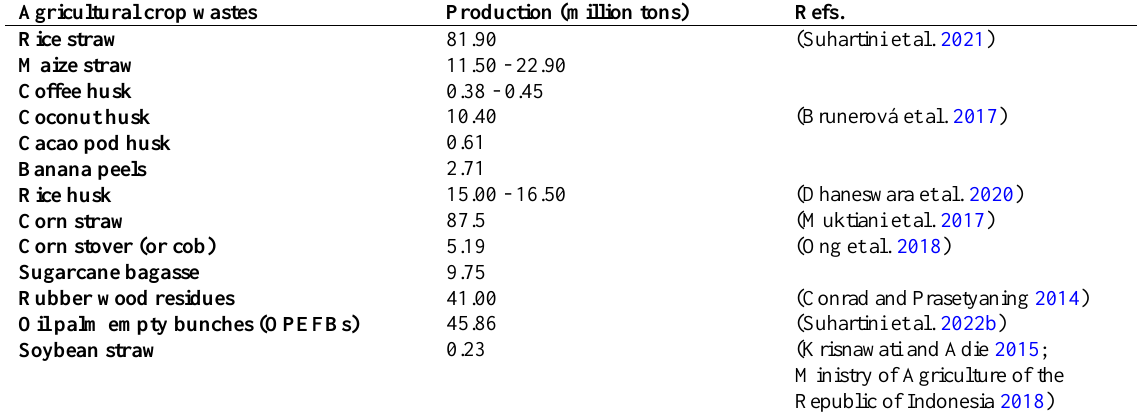
Table 1 The potency of agricultural crop waste in Indonesia Agricultural crop wastes